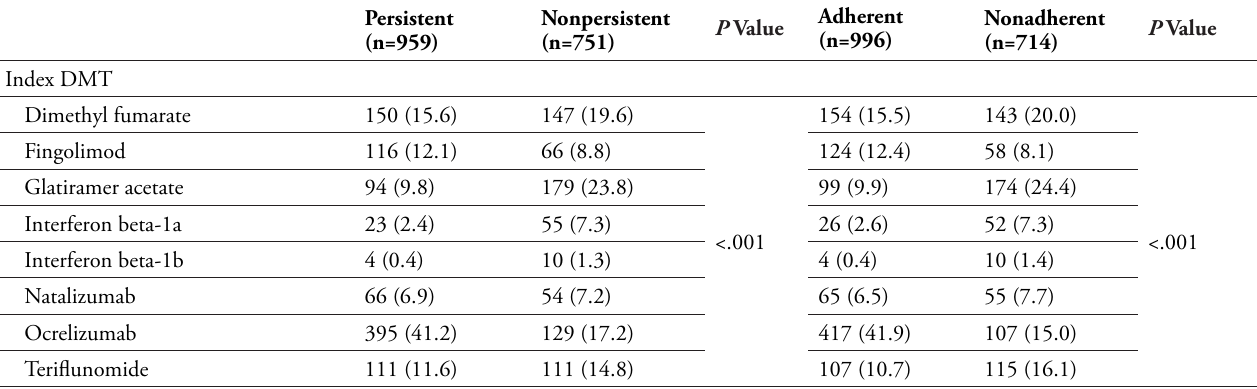
Table 1. Patient Demographic and Clinical Characteristics a (cont'd)